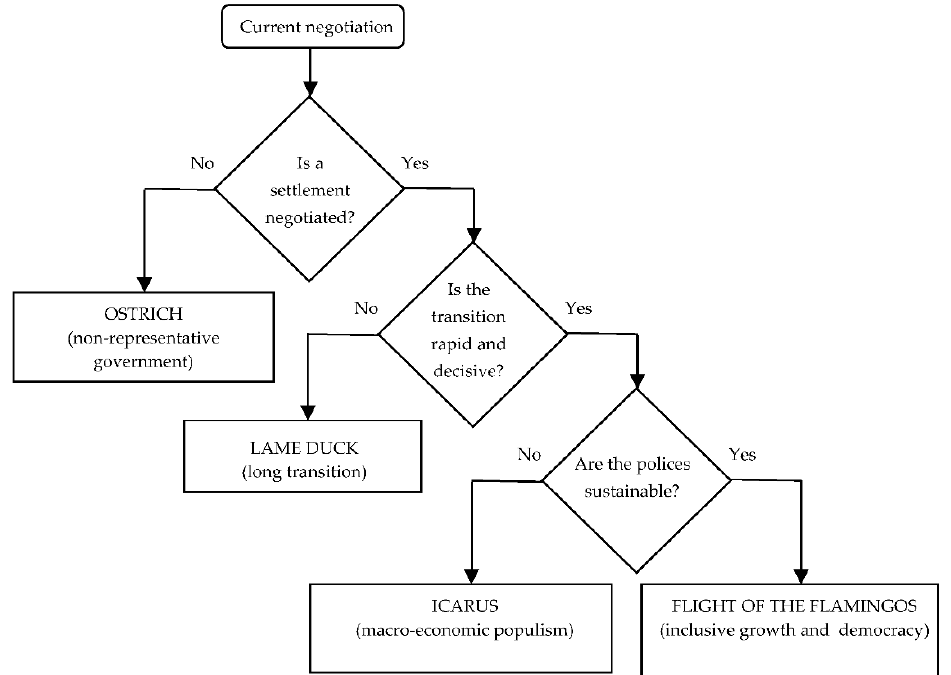
Figure 3. Mont Fleur Scenario structure. Source: [13] (p. 244).